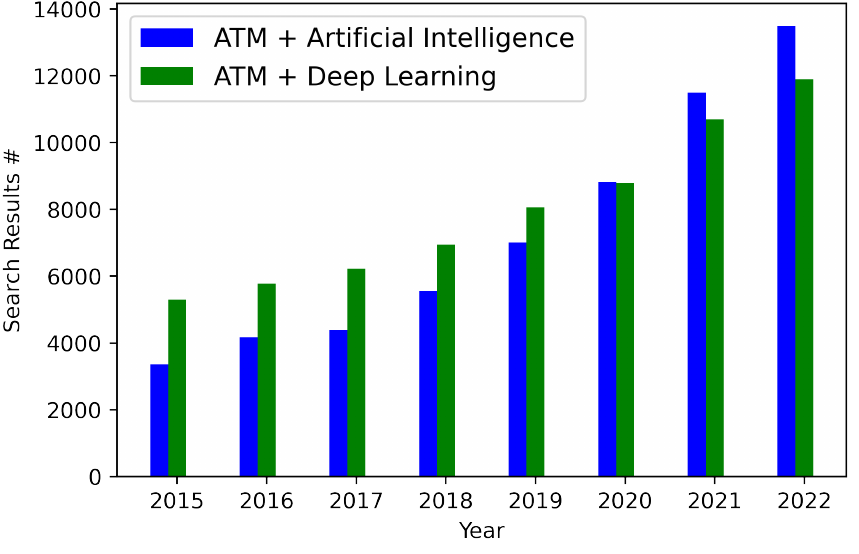
Figure 7. Evolution of AI and DL search results in ATM in the past few